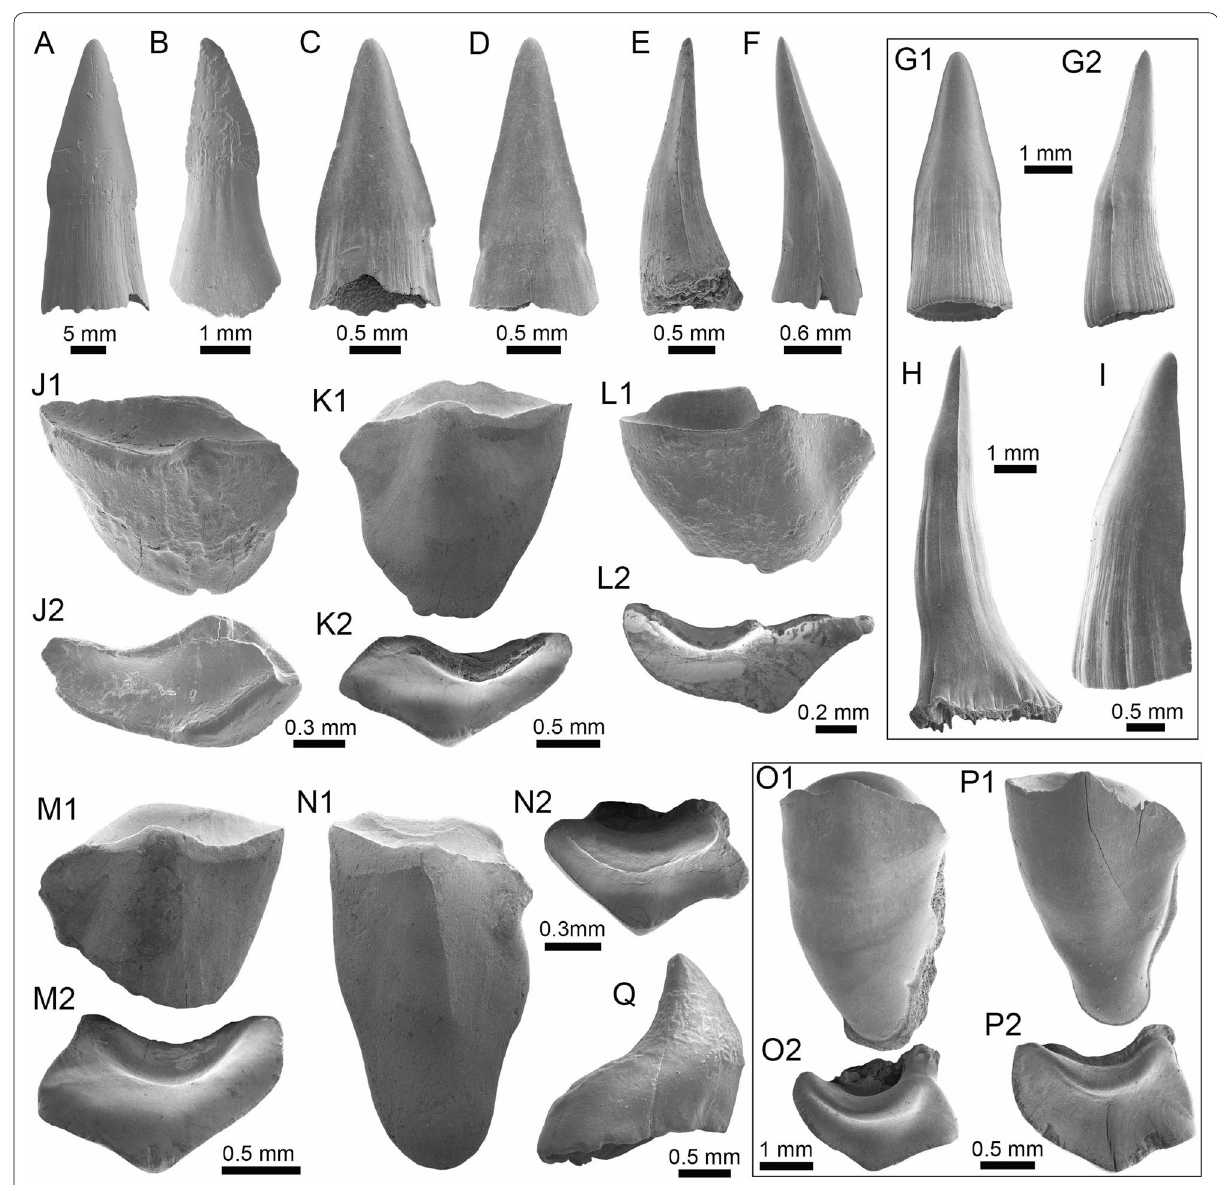
Fig. 6 Characiformes (Erythrinidae and Serrasalmidae) from the Vergel Member. A – F Hoplias sp. teeth of indeterminate position ( A , B AMU‑CURS‑860 and C – F AMU‑CURS‑824). G1 – I Recent teeth of Hoplias malabaricus (PIMUZ A/I 4875). J1 – N2 Mylossoma sp. symphyseal dentary teeth (AMU‑CURS‑1216). O1 – P2 Recent symphyseal dentary teeth of Mylossoma albiscopum (PIMUZ A/I 4860). Q Serrasalmidae indet. (? “pacu clade”) dentary tooth (AMU‑CURS‑859). Views: labial ( A , D , I , J1 , K1 , L1 , M1 , N1 , O1 , P1 ), lingual ( B , C , G1 ), occlusal ( J2 , K2 , L2 , M2 , N2 , O2 , P2 ), and lateral ( E , F , G2 , H , Q